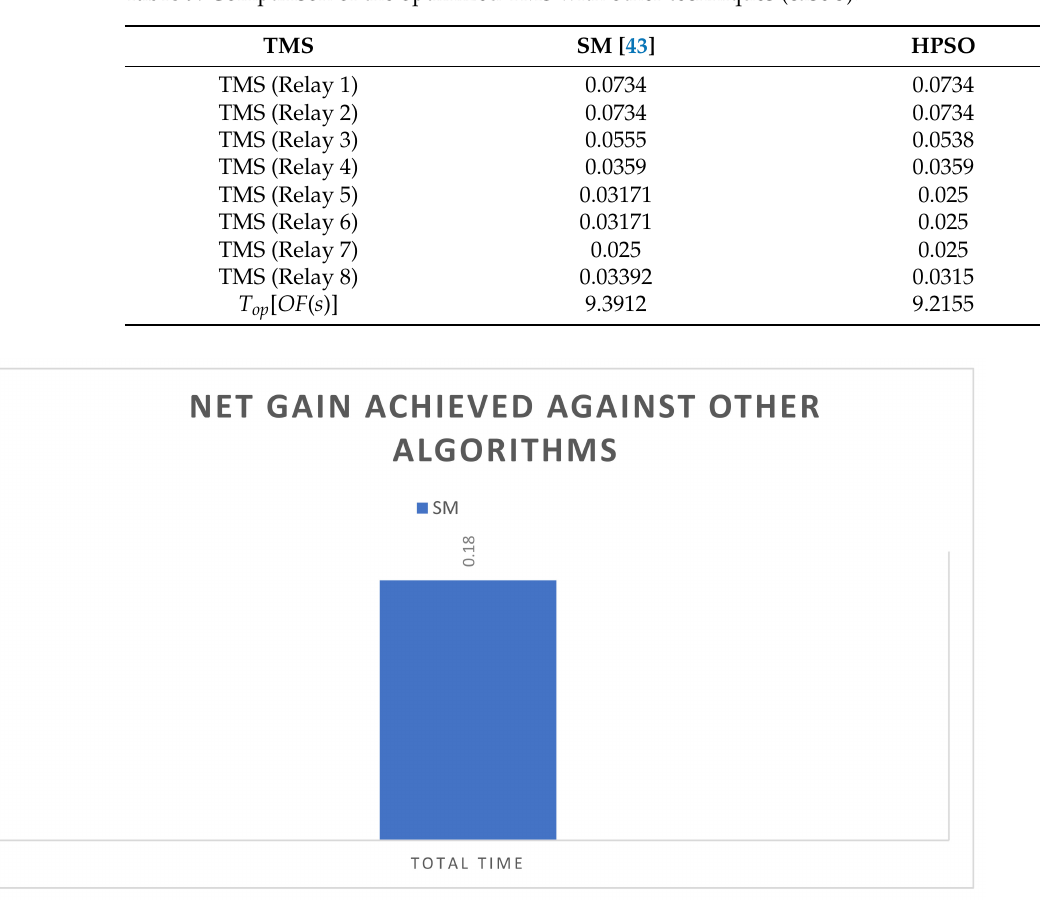
Figure 11. Comparison analysis of HPSO with other algorithm (Case 3).